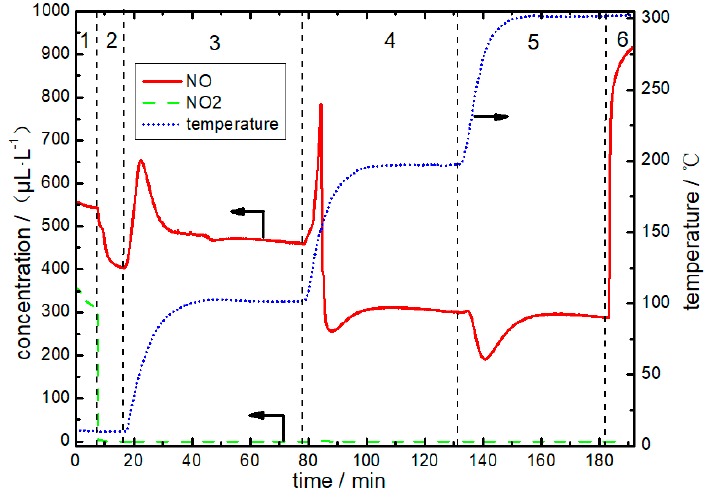
ff ect of AC on NO + NO